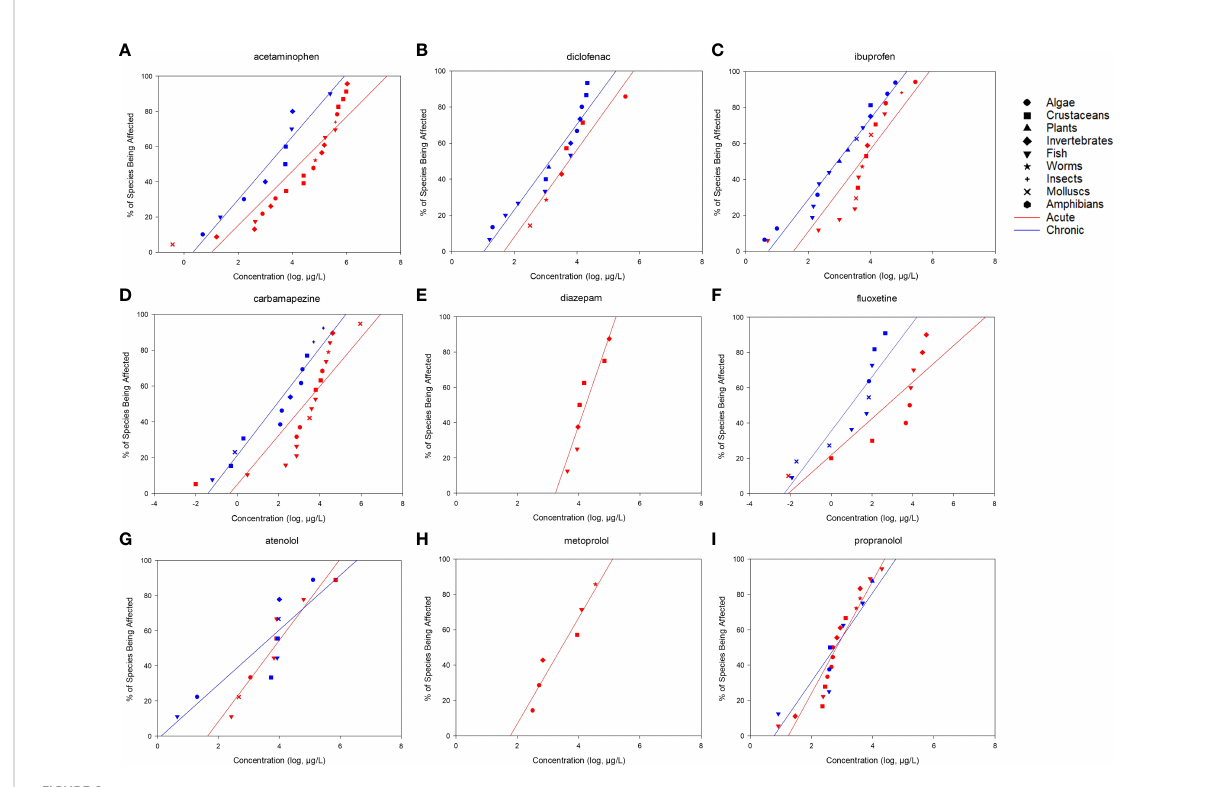
FIGURE 2 Freshwater acute (red) and chronic (blue) species sensitivity distributions (SSDs) for (A) acetaminophen, (B) diclofenac, (C) ibuprofen, (D) carbamazepine, (E) diazepam, (F) fl uoxetine, (G) atenolol, (H) metoprolol, (I)